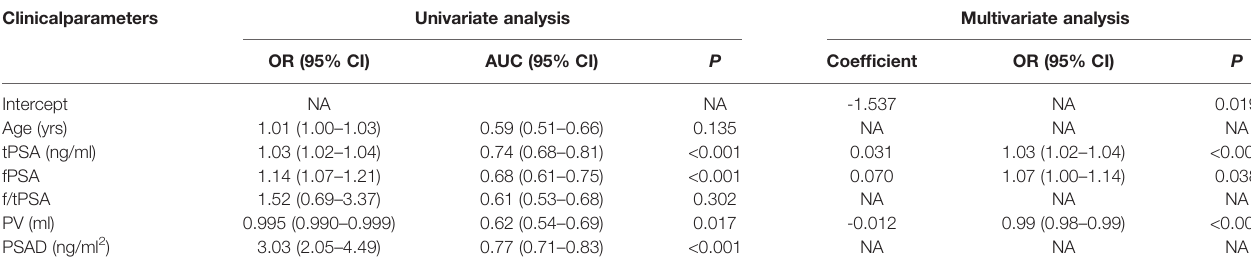
TABLE 2 | Univariate and multivariate regression analysis of clinical parameters to predict suspicious MRI-PCa in the validation cohort.